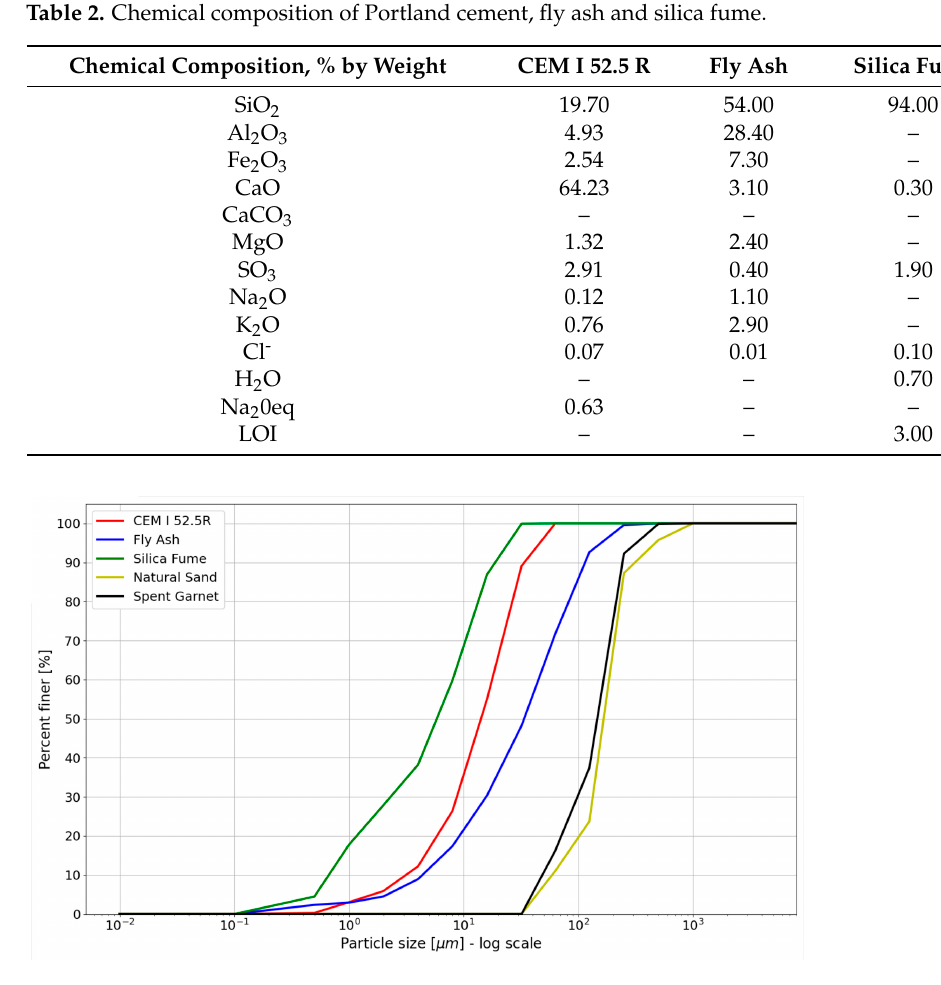
Figure 3. Particle size distribution of materials in the study.